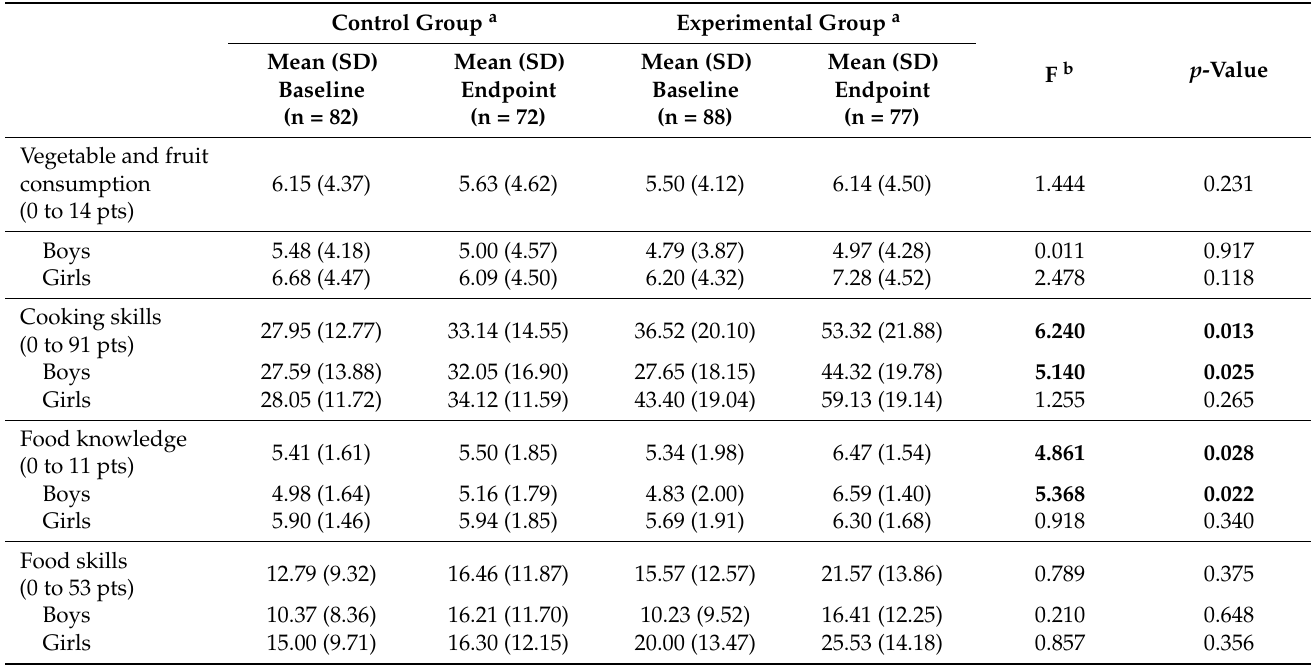
Table 2. Differences in vegetable and fruit consumption, cooking skills, food skills, and food knowl- edge between the experimental and control groups. Control Group a